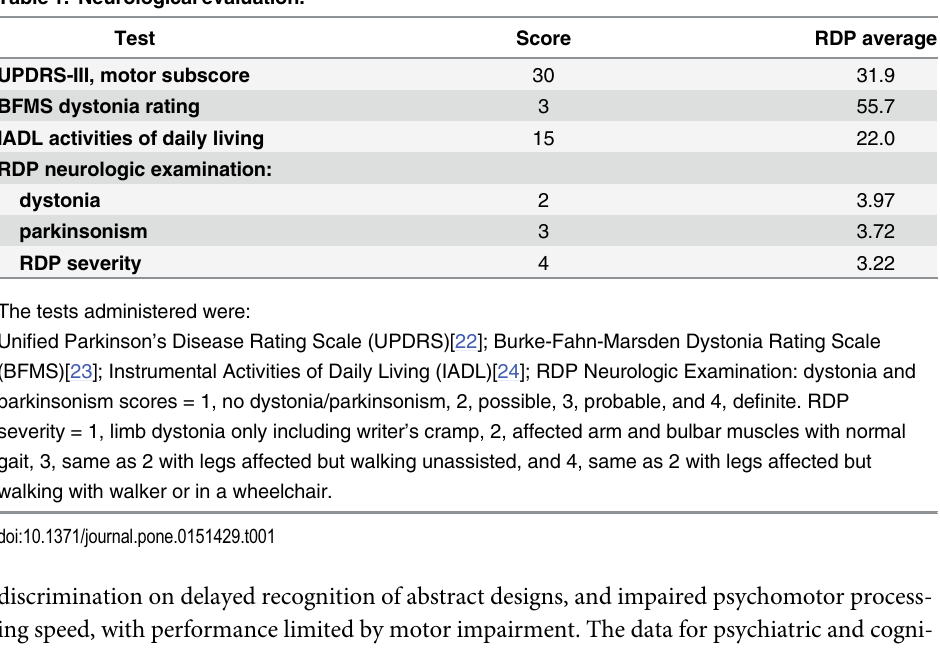
Table 1. Neurological evaluation.